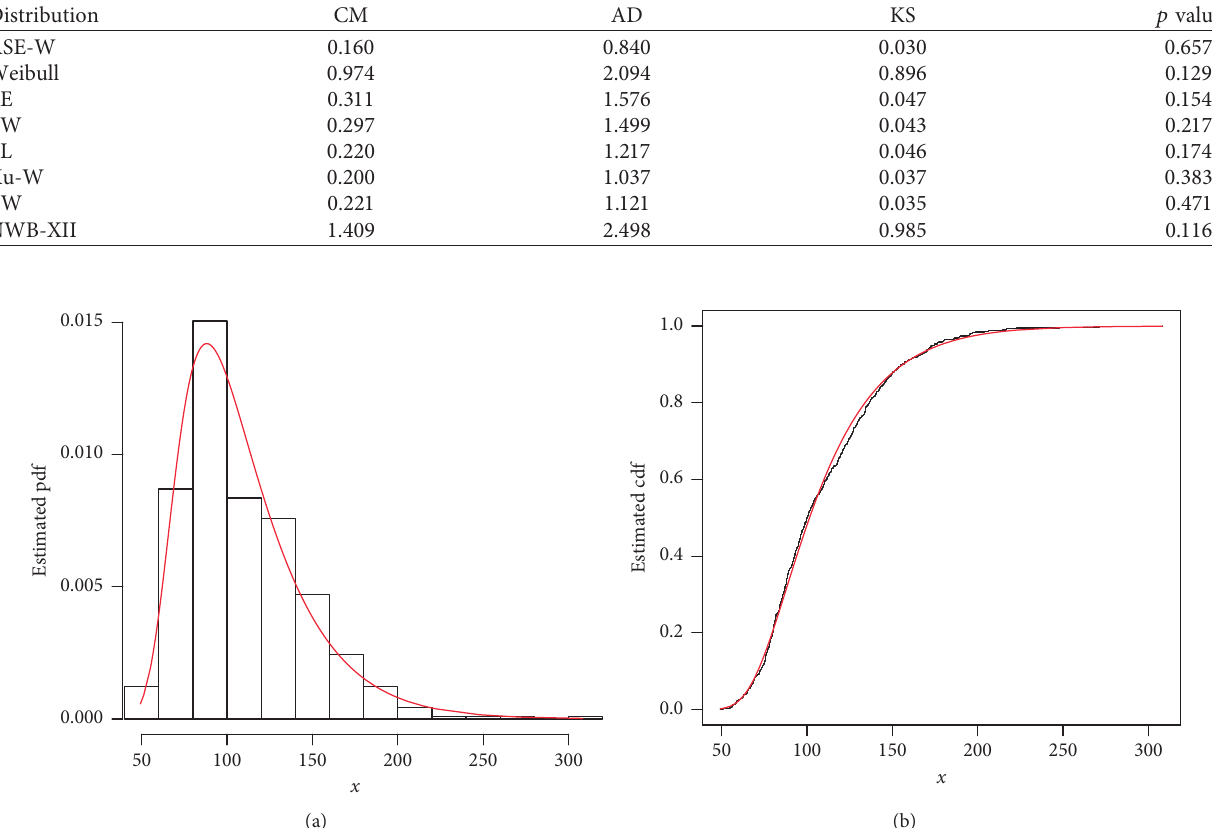
Table 9: Goodness-of-fit measures of the ASE-W model and other competing models.